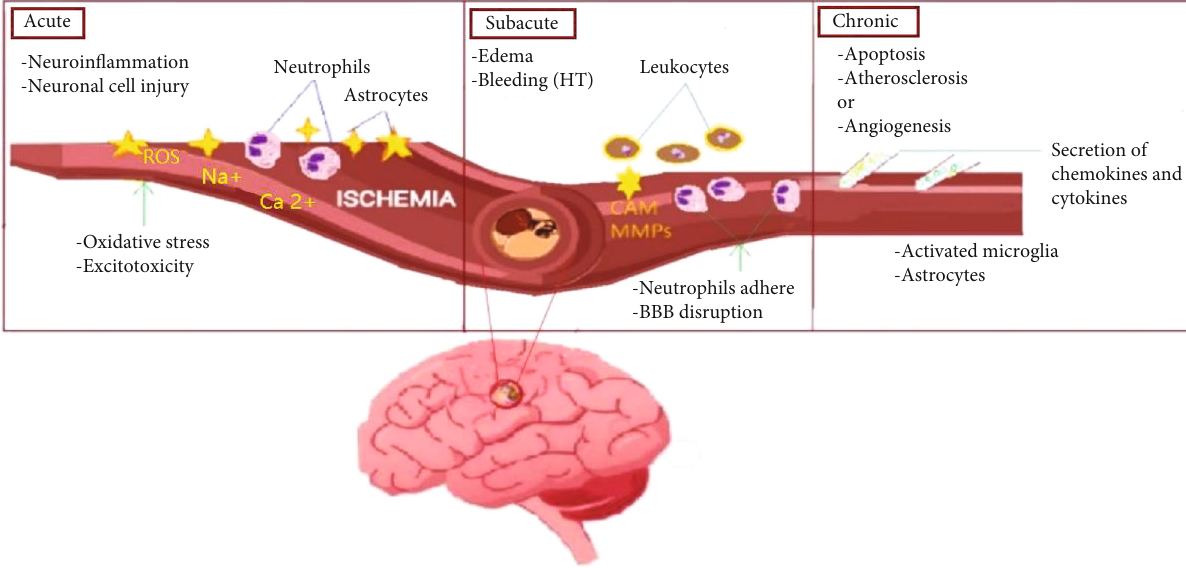
Figure 1: Graphical presentation of the various stages of cerebral ischemia stroke, i.e., acute phase, subacute phase, and chronic phase and their contributing